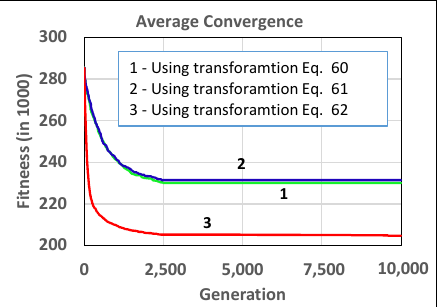
Figure 16. The average convergence from ten test runs of 2SGA using proportional selection under three different fitness transformation while solving Problem-4.